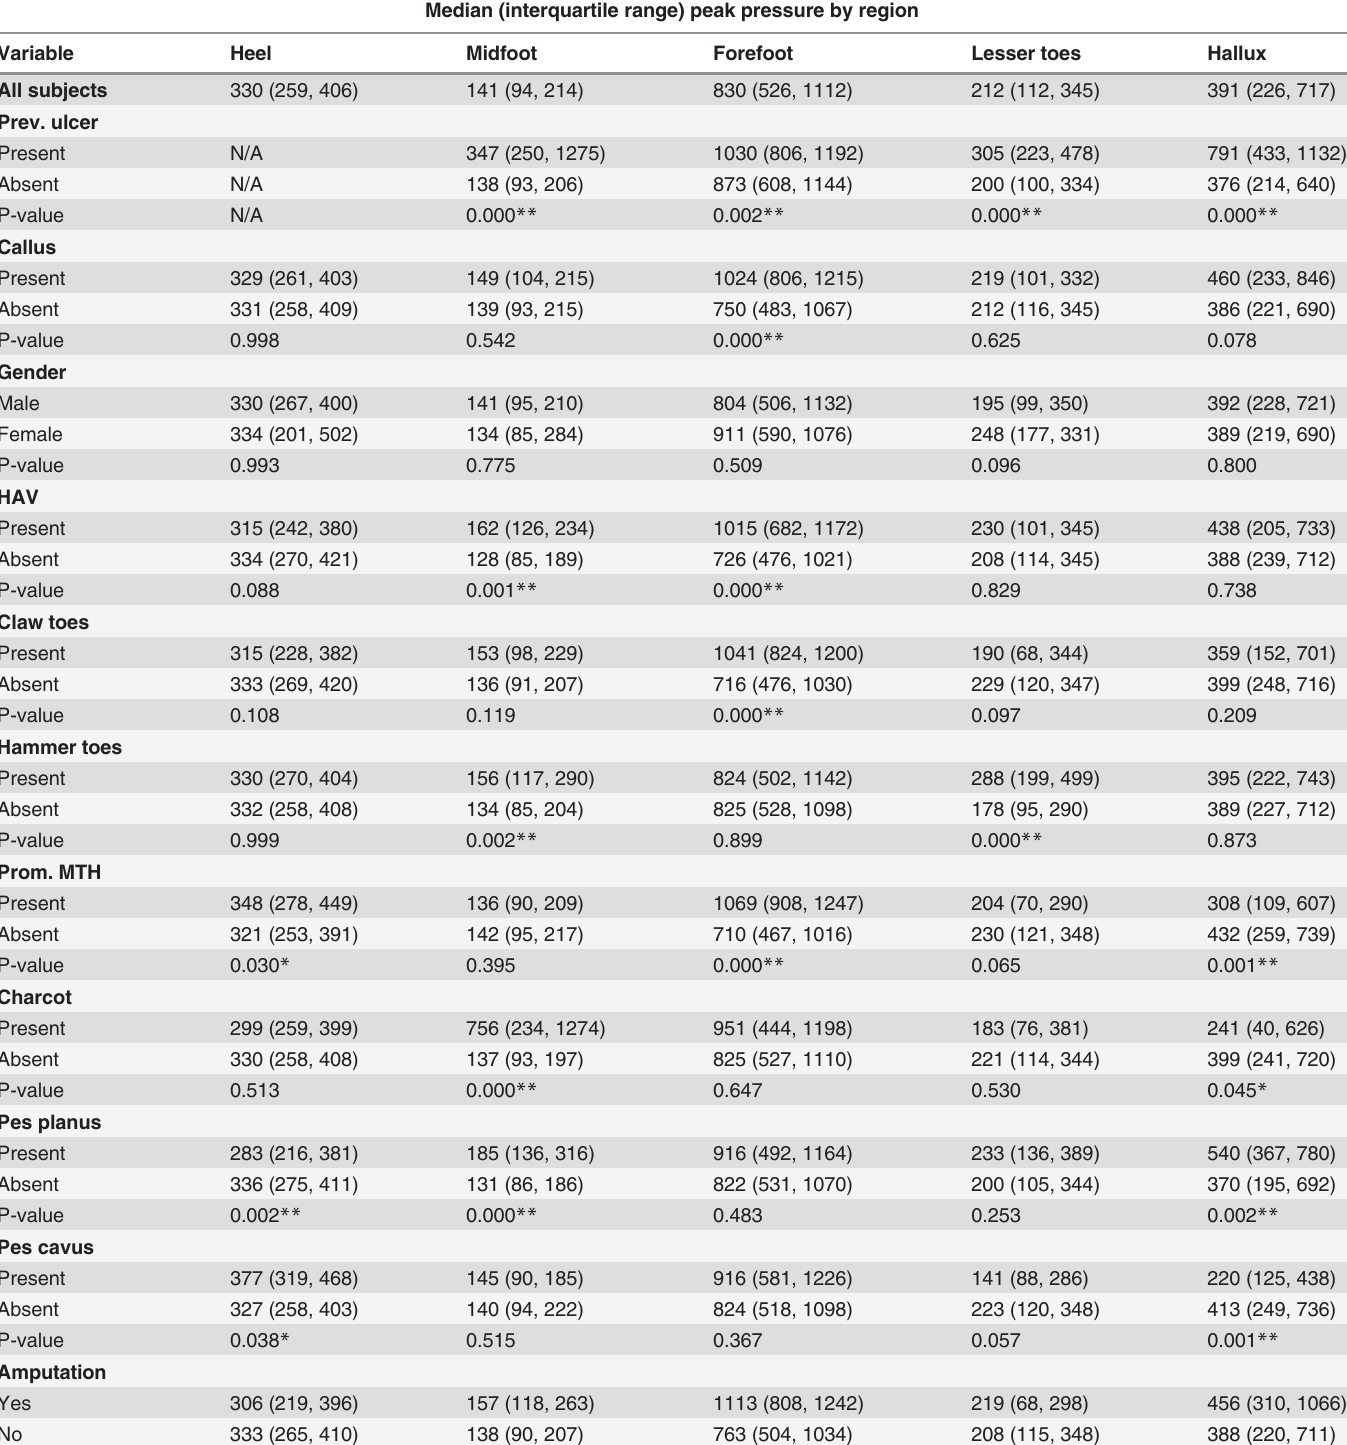
Table 2. Descriptive summary of barefoot plantar pressure by categorical predictor